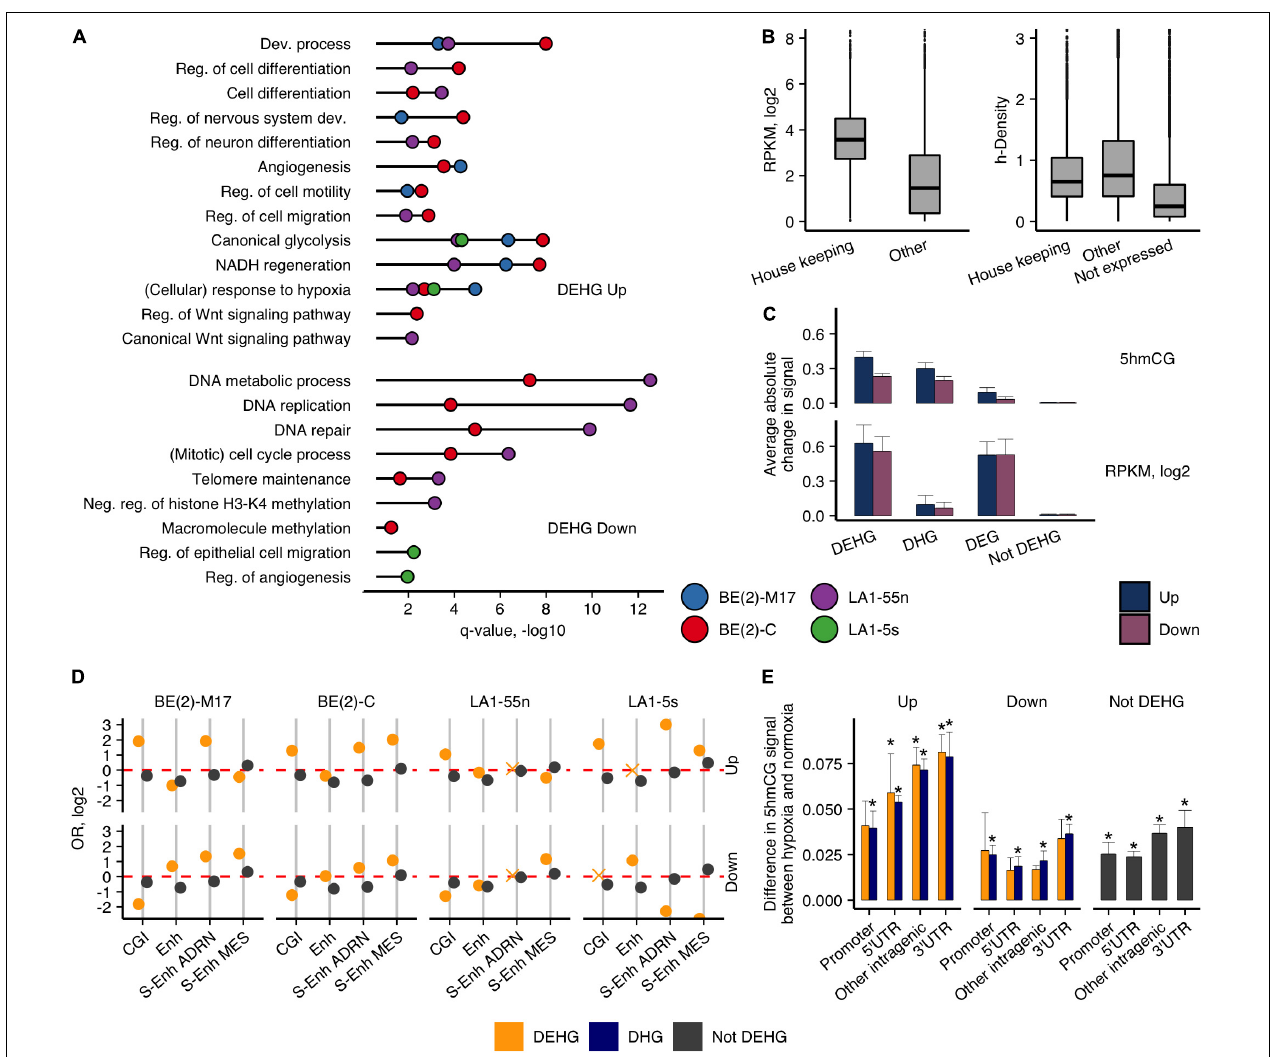
FIGURE 2 | 5hmCGs distributed differently in expressed genes of hypoxic and normoxic NB cells. (A) GO functional annotation analysis of the hypoxic Up- and Down-DEHG with 5hmCG gain and loss, respectively. Reg., regulation; Dev., development; Proc., process; Diff., differentiation. q -value represents enrichment significance after Benjamini and Hochberg correction. (B) h-density and RNA levels for the housekeeping genes in relation to other expressed and unexpressed genes combined for all NB cell lines ( p -values between housekeeping and other genes for both comparisons were < 2.2e-16, Wilcoxon signed-rank test). (C) Absolute average change of the 5hmCG (upper panel) and RNA (bottom panel) signals between the up and down subgroups of DEHGs, DHGs, DEGs, and not DEHGs (genes without expression or 5hmCG changes). (D) OR for enrichment of the 3 (cid:48) UTRs of the protein-coding genes for CGIs and NB-defined Enhs (data